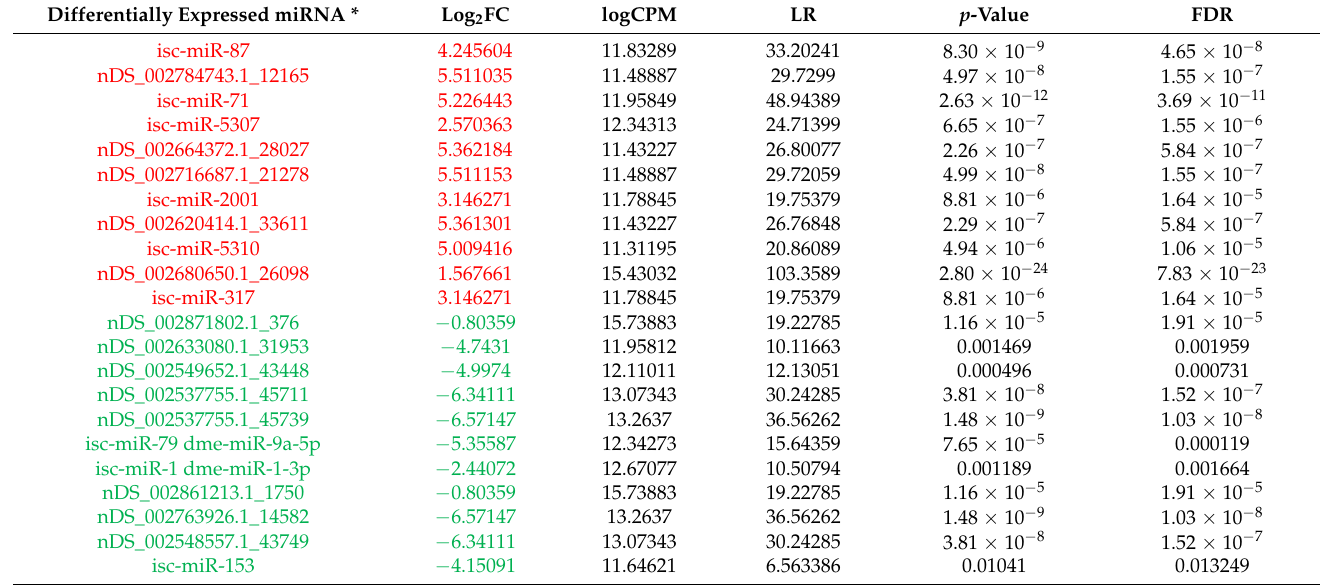
Table 1. In silico differential expression of Ixodes scapularis miRNAs in salivary glands after Borrelia burgdorferi infection compared with uninfected salivary glands.